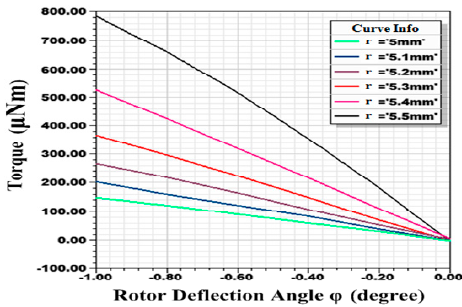
Figure 5. Restoring torques with different radius ( r values) under deflection angles from − 1° to 0°.